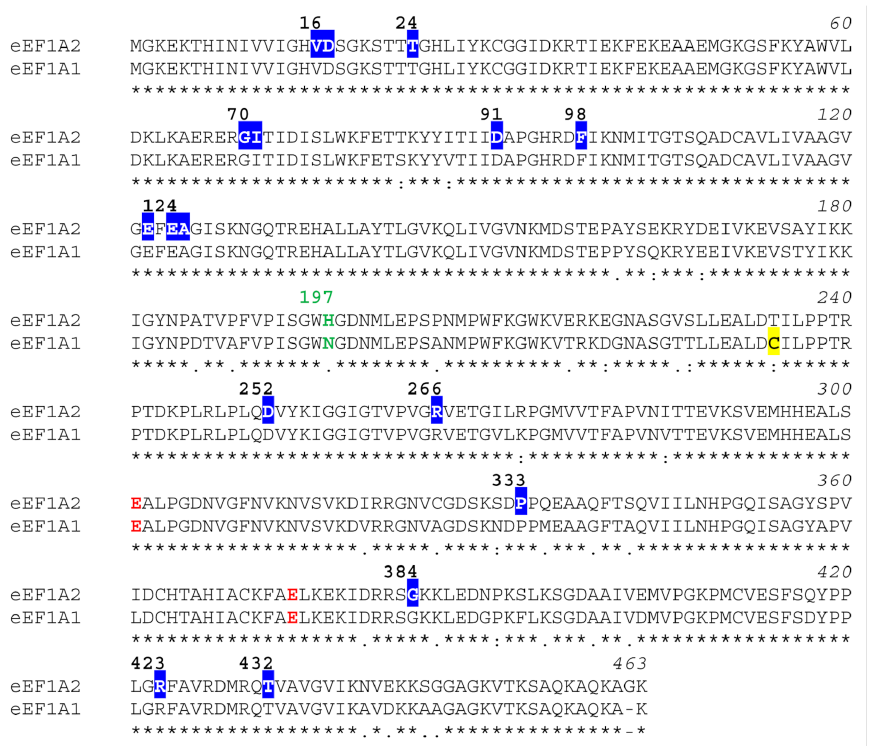
Figure 1. Sequence alignment of human eEF1A1 (EF11_HUMAN) and human eEF1A2 (EF12_HUMAN), which is 100% identical to rabbit eEF1A2 (mouse and rat eEF1A2 proteins only differ in one amino acid: Ser/Asn331Ala). The protein sequences were obtained from UniProtKB [54] and the alignment was produced with Clustal Omega [55]. Asterisks, colons and dots designate identical residues, conserved substitutions and semiconserved substitutions in the aligned sequences, respectively. The two Glu residues identical to those undergoing EFG modification in rabbit eEF1A2 (Glu301/Glu374) are colored in red. Cys234 in eEF1A1, which is essential for oligomerization) [56], is highlighted in yellow. Amino acids that are replaced upon missense mutations in the human EEF1A2 gene and have been associated with severe neurological disorders are boxed and numbered. The amino acid at position 197 is colored in